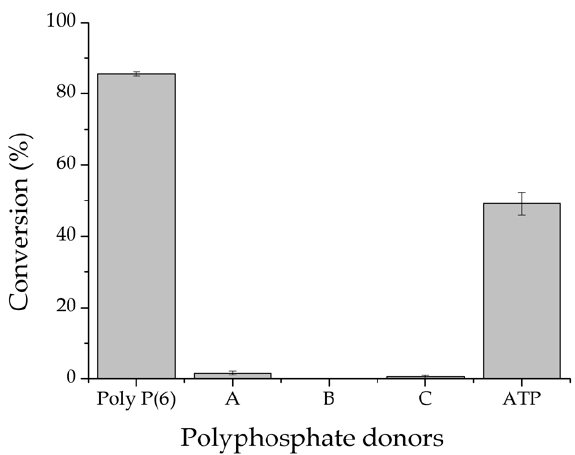
Figure 10. Optimization of polyphosphate donors in terms of conversion efficiency with polyphosphate-dependent mannose kinase, mannose (20 g/L), at 30 °C at pH 8.5. A, B, and C represent sodium trimetaphosphate, sodium tripolyphosphate, and sodium pyrophosphate, respectively. This enzyme was more selective for polyphosphates than ATP and was not selective for A, B, and C.